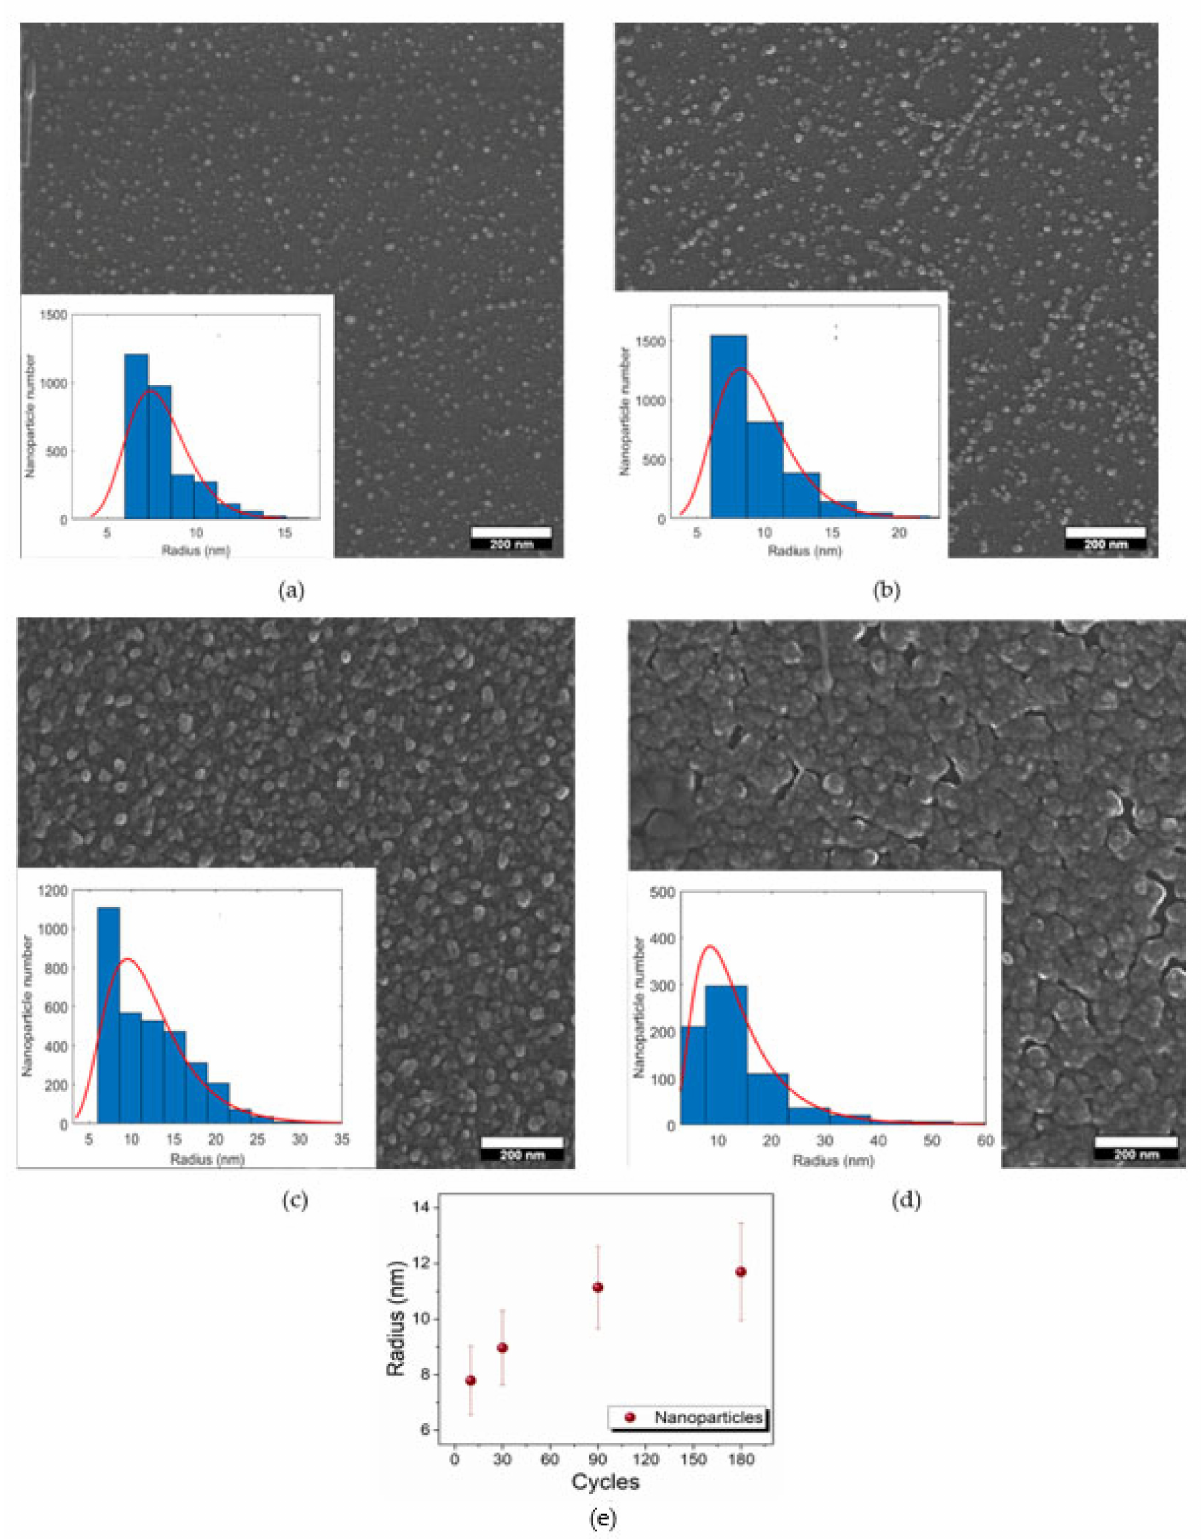
Figure 4. SEM images of: ( a ) sample D, 10 cycles; ( b ) sample E, 30 cycles; ( c ) sample F, 90 cycles; ( d ) sample G, 180 cycles; ( e ) correlation between the dimensions of the nanoparticles and the number of the deposition cycles. The insets of figures a-d show the statistical analysis of the dimension of the nanoparticles performed on the SEM